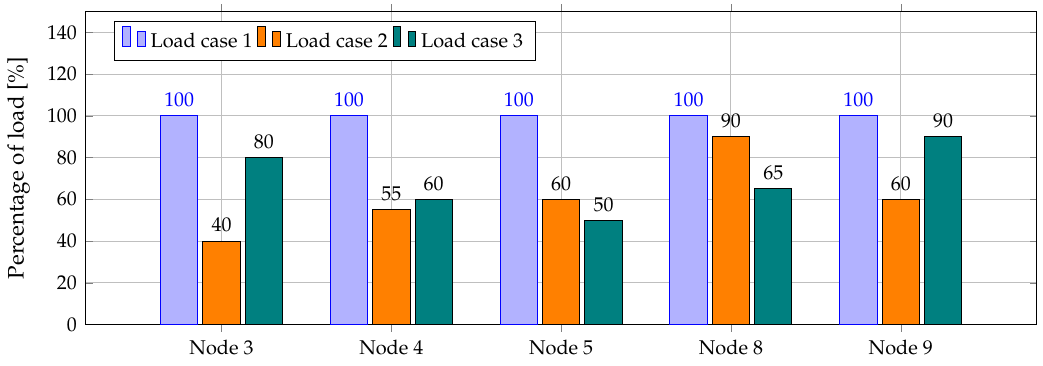
Figure 6. Three load demand scenarios in constant power loads.